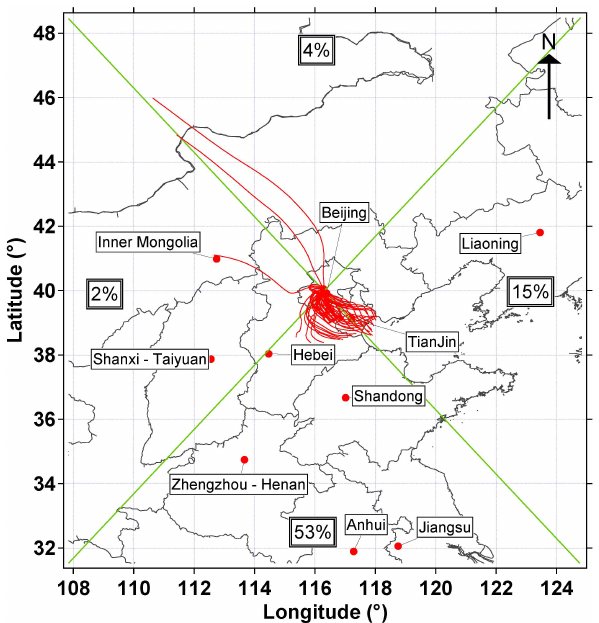
Fig. 11. Geographical map showing the 24-h backward trajecto- ries arriving at Beijing during the intensive summer measurements, reconstructed using the NOAA ARL HYSPLIT trajectory model (http://ready.arl.noaa.gov./HYSPLIT.php).